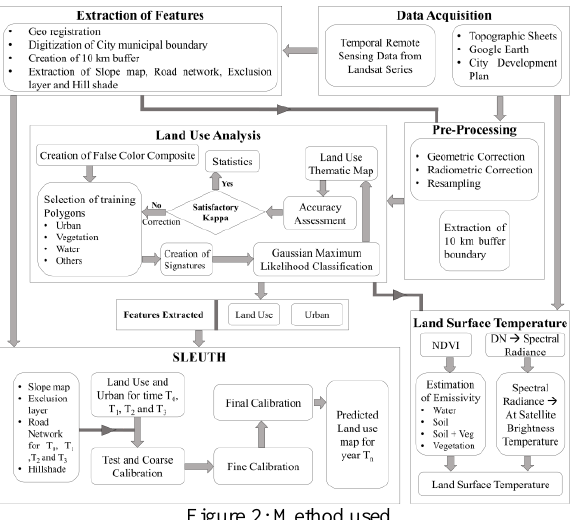
Figure 2: Method used